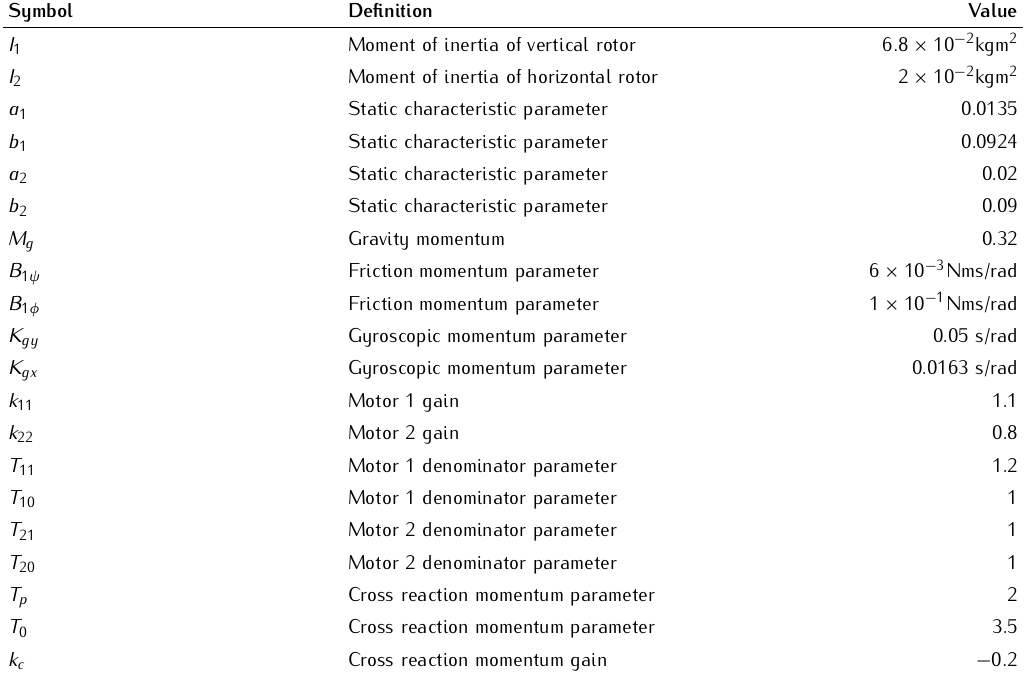
Table 1. Physical parameters of the TRMS